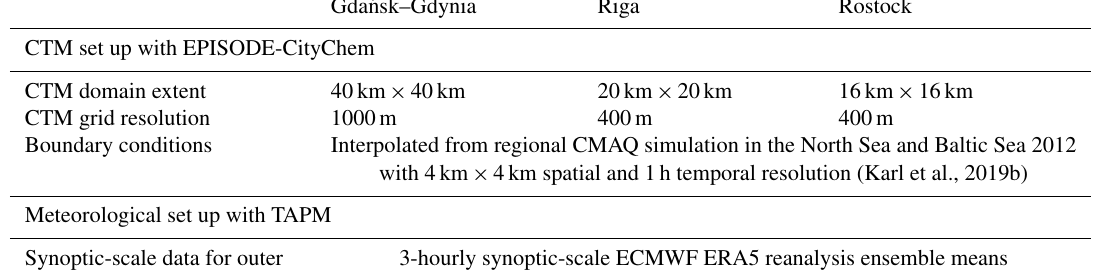
Figure 1. Study design to calculate microenvironment-specific population exposure to outdoor air pollution based on CTM concentration simulations and taking into account seasonally changing infiltration factors for indoor environments. Table 1. Overview of EPISODE-CityChem set-up, the TAPM meteorological set-up and emission data for each urban domain. Gda´nsk–Gdynia